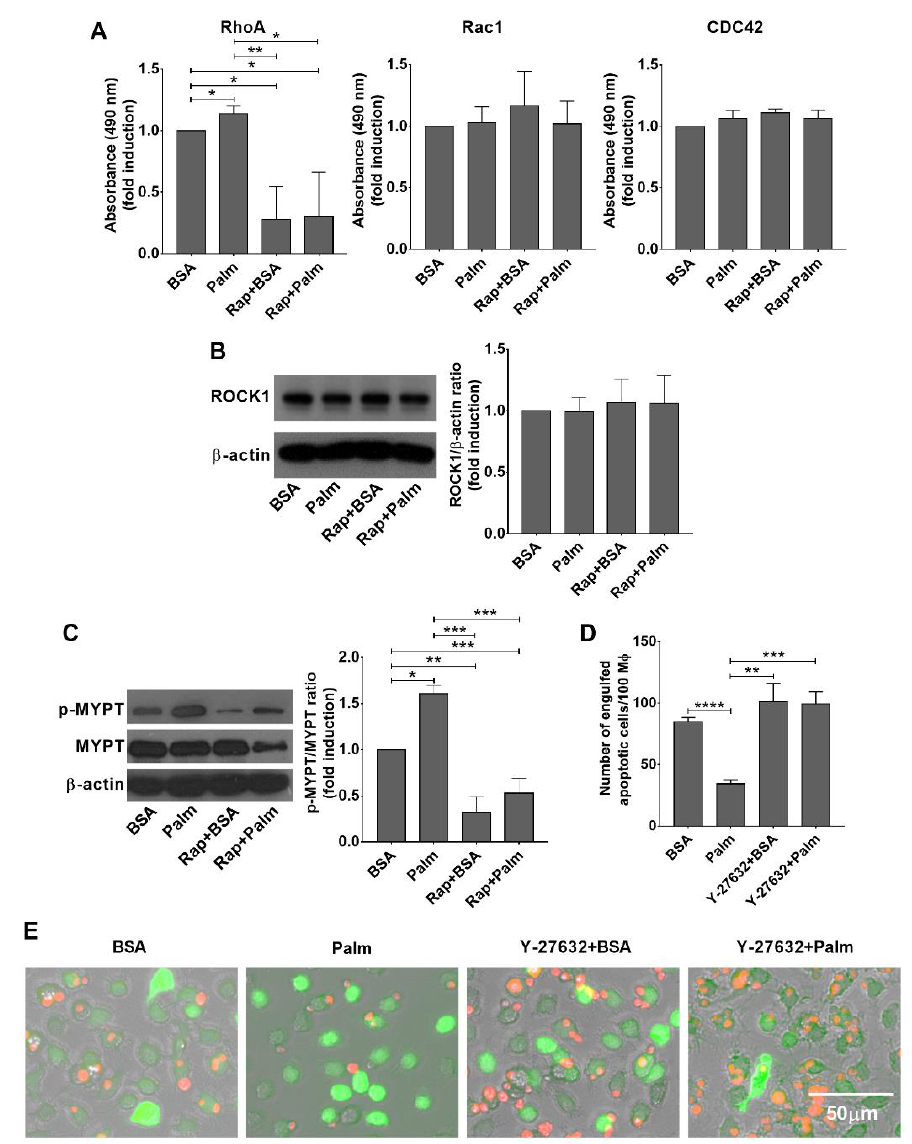
Figure 4. Exposure of BMDMs to palmitate results in an mTORC1-dependent ROCK1 activation leading to inhibition of efferocytosis. ( A ) Exposure of BMDMs to 0.4 mM palmitate for 24 h leads to enhanced mTORC1-dependent RhoA activity detected by G-LISA RhoA activation assay kit, while the activity of Rac1 and Cdc42 did not alter. ( B ) Exposure of BMDMs to 0.4 mM palmitate for 24 h did not affect the ROCK1 protein expression levels detected by Western blot analysis. β -actin was used as a loading control. One representative gel of three is shown. ( C ) Exposure to 0.4 mM palmitate for 24 h leads to an increased mTORC1-dependent Thr 850 phosphorylation of MYPT-1, a downstream substrate of ROCK1 detected by Western blot analysis, while addition of rapamycin (100 nM) reverses this effect. β -actin was used as a loading control. One representative gel of three is shown. ( D ) Y-27632 (30 µ M), a ROCK inhibitor, reverses the efferocytosis inhibition of BMDMs induced by palmitate exposure for 24 h detected by counting the number of engulfed cells. All data are expressed as mean ± SD ( n = 4). Asterisks indicate statistically significant difference (* p < 0.05, ** p < 0.01, *** p < 0.001, **** p < 0.001). ( E ) Representative fluorescent microscopic images of macrophages (green) engulfing apoptotic thymocytes (red) following 40 min of efferocytosis in the presence and absence of 0.4 mM palmitate with or without 30 µ M